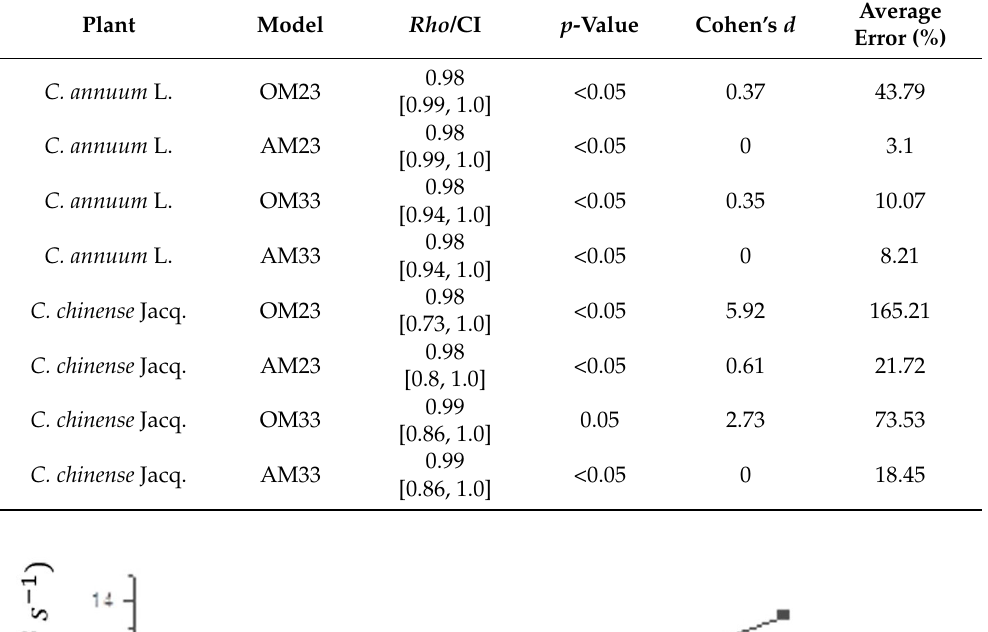
Table 5. The statistical values of the net photosynthesis estimate compared with the original model M23 (OM23), the fitted model M23 (AM23), the original model M33 (OM33), and the fitted model (AM33). All statistics were calculated for Capsicum annuum L. ( C. annuum L.) and Capsicum chinense Jacq. ( C. chinense Jacq.). Measurements in Capsicum annuum L. were carried out at 23 ◦ C for M23 and at 33 ◦ C for M33. To study the behavior of the model, measurements were made on Capsicum chinense Jacq. they were prepared at 29.8 ◦ C, and compared with M23 and M33. Plant Model Rho /CI p -Value Cohen’s d